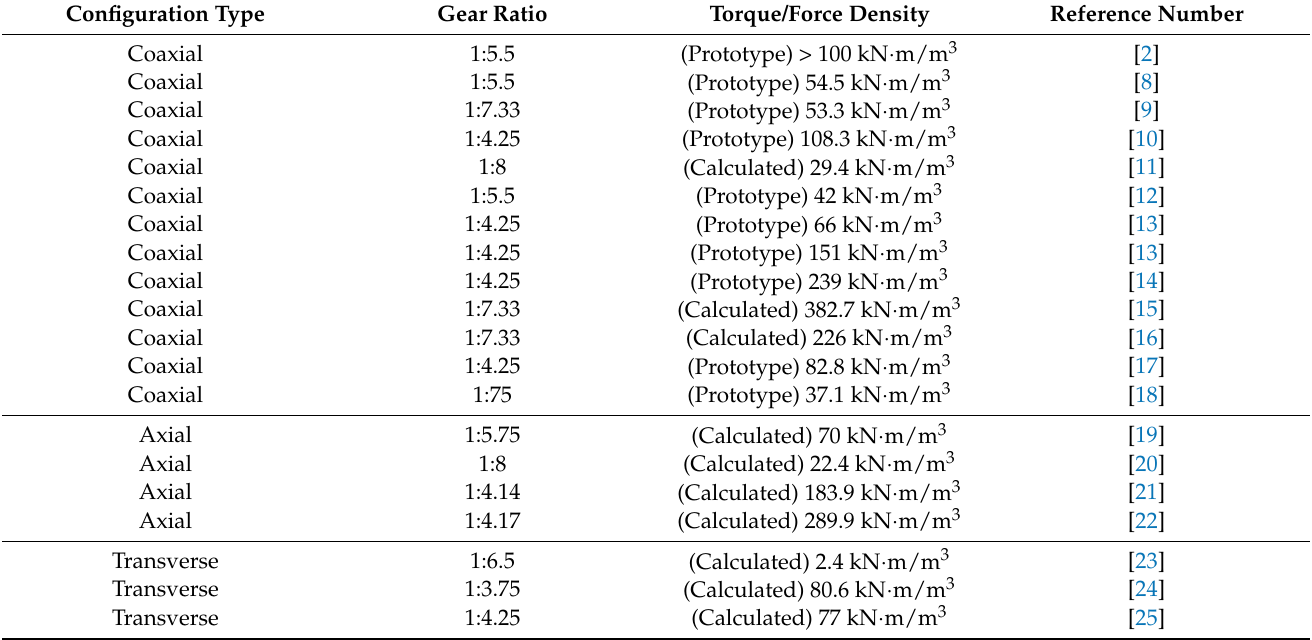
Table 1. Summary on FM-MGs